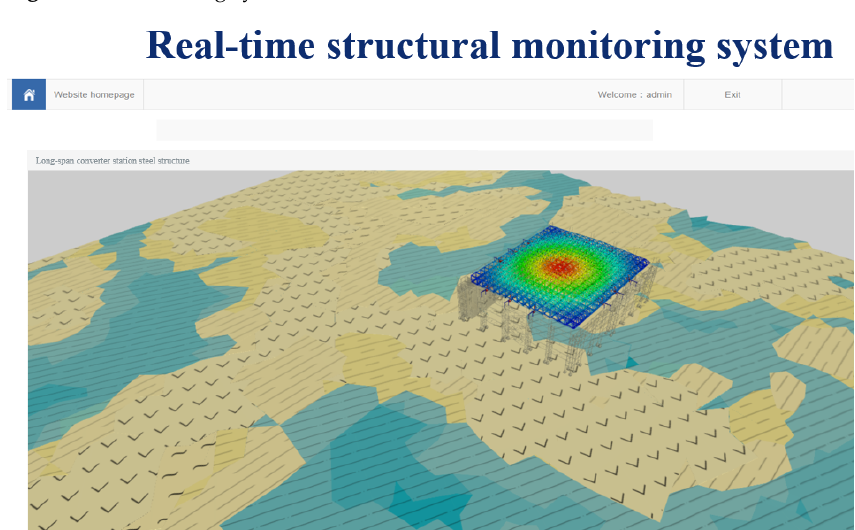
Figure 16. Monitoring system function page.